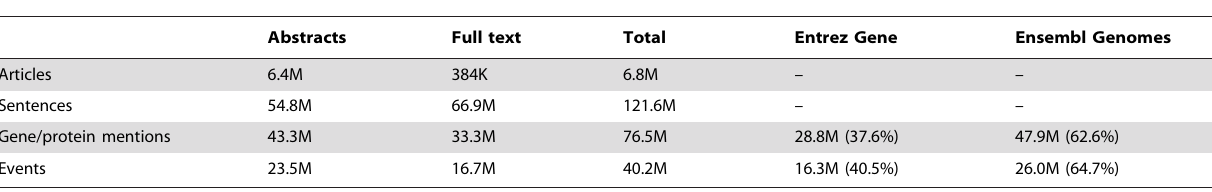
Table 3. Overview of extraction